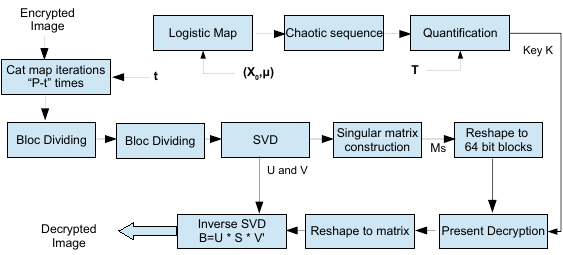
Figure 9. Flowchart of the decryption procedure employed.